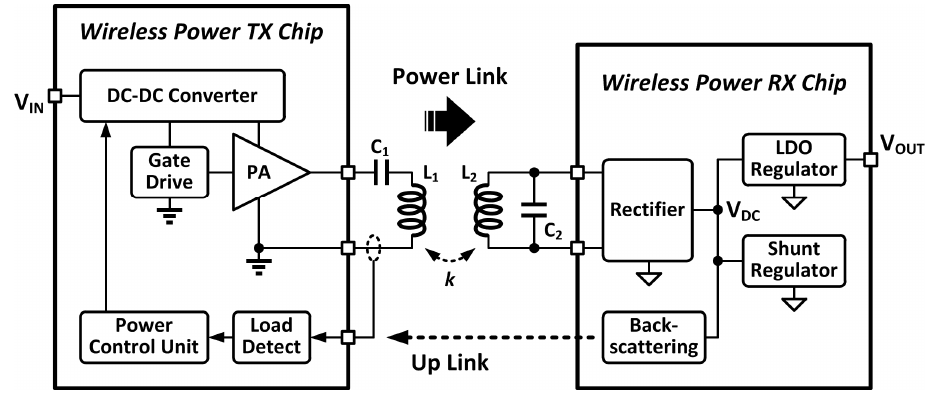
Figure 2. A typical inductive WPT system with linear regulators and data up-link through load modulation for power control. modulation for power